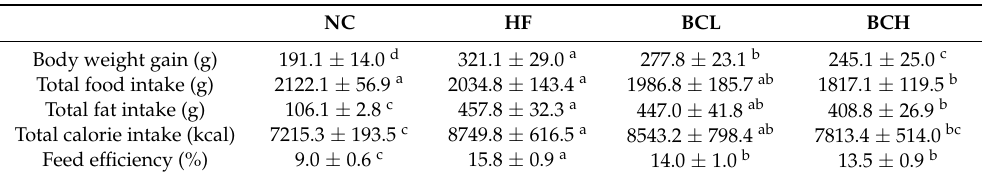
Table 1. Summary of body weight gain, total food and fat intakes, total calorie intake, and feed efficiency among different